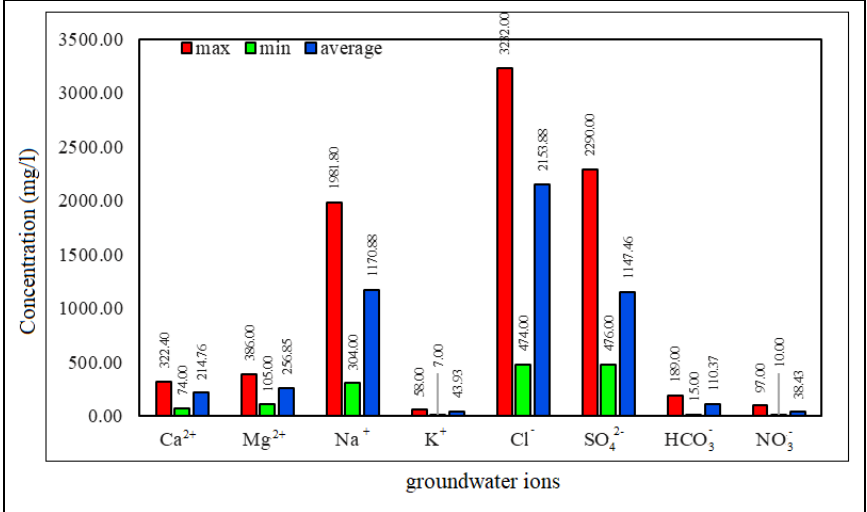
Figure 3. Statistical presentation of groundwater ions.